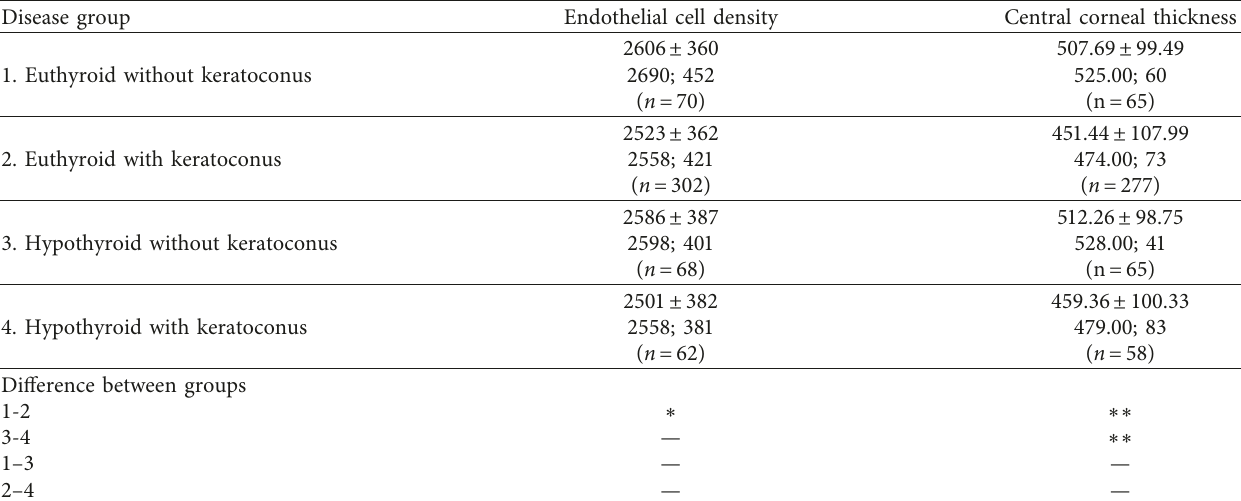
Values represent the mean ± standard deviation or the median; interquartile range, as indicated. ∗ p < 0 . 05; ∗∗ p < 0 .